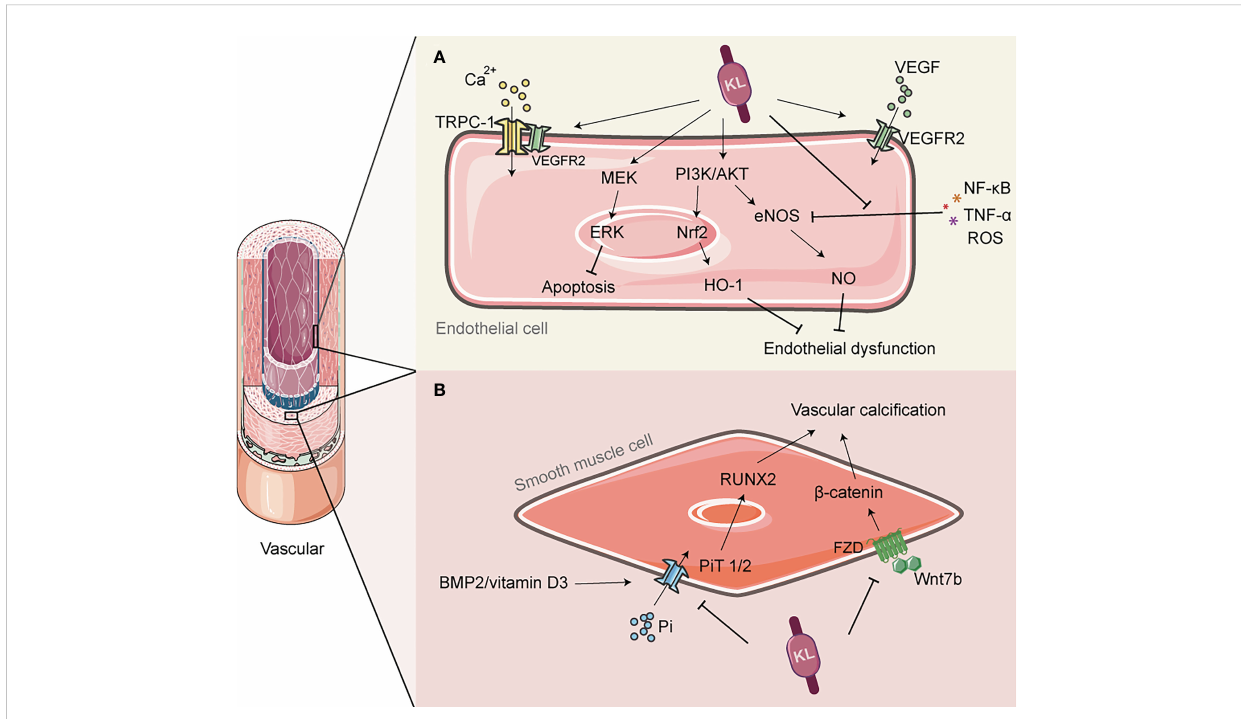
FIGURE 2 The role of Klotho in vascular protection. (A) Klotho can activate PI3K/AKT/Nrf2/HO-1 to enhance endothelial antioxidant defense; It can also activate PI3K/Akt/eNOS pathway, and alleviate the inhibition of eNOS phosphorylation by in fl ammatory factors such as TNF- a , thereby promoting NO production and preventing endothelial cell dysfunction. Klotho is involved in the transmission of VEGF signaling and regulates Ca2+ in fl ux, which helps to maintain endothelial integrity. (B) Klotho inhibits phosphate uptake by vascular smooth muscle cells (VSMCs), leading to improved vascular calci fi cation. It also inhibits the PiT2/RUNX2 signaling pathway, which improves extracellular matrix calci fi cation. Additionally, Klotho inhibits the Wnt7b/ b -catenin signaling pathway, which prevents VSMC calci fi cation. NO, nitric oxide; eNOS, endothelial nitric oxide synthase; PI3K, Phosphoinositide 3-kinase; AKT, protein kinase B; Nrf2, Nuclear factor erythroid 2-related factor 2; HO-1, heme oxygenase-1; TRPC-1, transient- receptor potential canonical Ca(2+) channel 1; VEGF, vascular endothelial growth factor; PiT, Pi transporter; RUNX2, runt-associated transcription factor